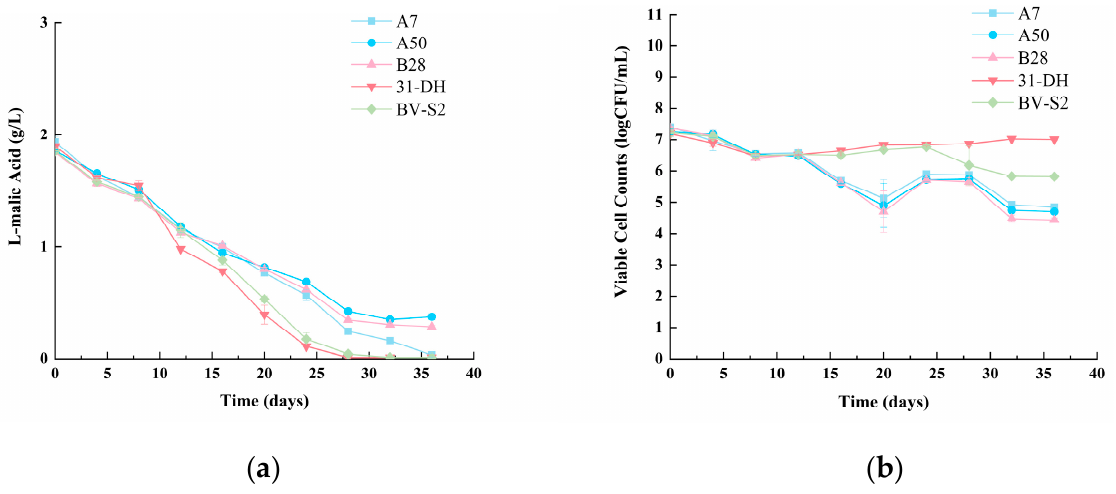
Figure 8. Enological characteristics of L. plantarum : ( a ) L-malic acid consumption rate during MLF; ( b ) the viable cell counts during